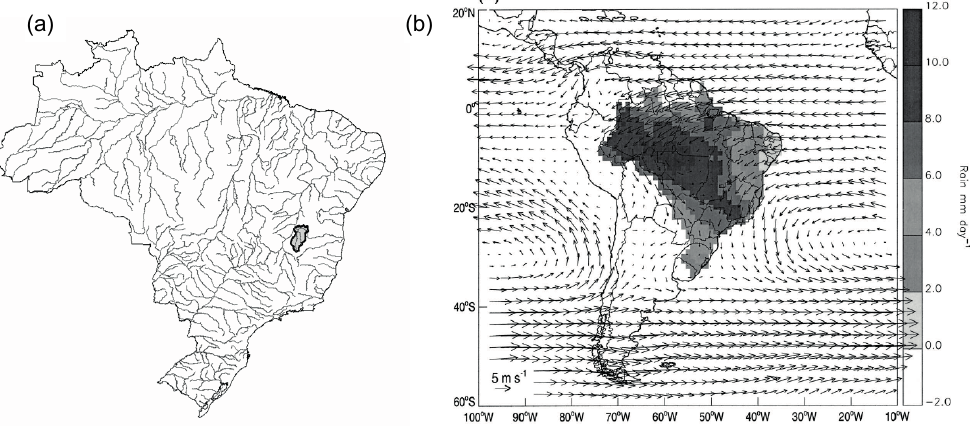
Fig. 1 Location of the Verde Grande River Basin (a) and position and intensity of SACZ rainfall (Carvalho et al. 2003,